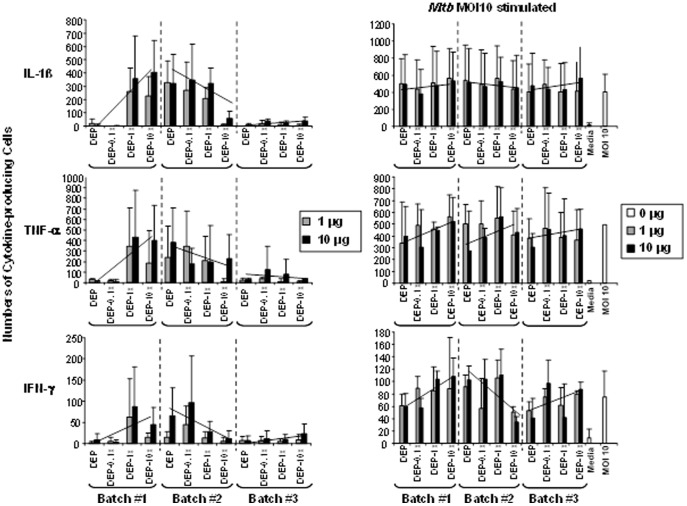
Effects of DEP and DEP-Env Exposure on Cytokine Expression in Human PBMC.PBMC from healthy donors (n = 3) were exposed to indicated concentrations of DEP, DEP-0.1x, DEP-1.0x, and DEP-10x from three independent batches (#1-3) in absence (left panel) or presence (right panel) of M.tb H37Ra at a multiplicity of infection of 10 (10 M.tb bacteria per blood monocyte within the PBMC) (0 µg/mL) for 24 hours. Frequencies of IL-1β, TNF-α and IFN-γ-producing PBMC were assessed by ELISPOT assay. Y-axes represent cytokine spot frequencies (numbers) of cytokine-producing cells (mean ± SD). To demonstrate the change in the expression profile of cytokine-producing cells exposed to DEP, DEP-0.1x, DEP-1.0x, and DEP-10x from batches #1-3, straight lines indicating the trend are inserted.